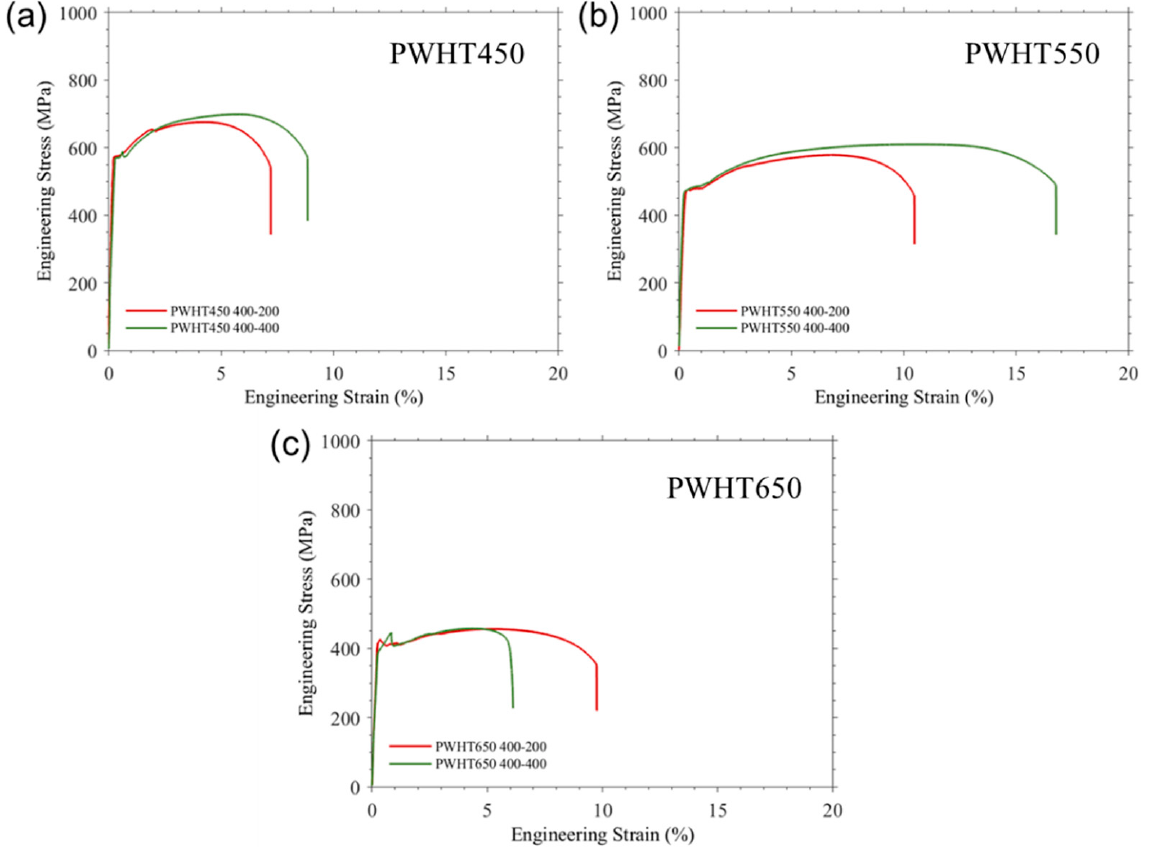
Figure 7. Representative stress-strain curves of the samples subjected to subsequent annealing with different temperatures of ( a ) 450 °C, ( b ) 550 °C, and ( c ) 650 °C. Table 4. Resultant tensile properties of FSWed DP780 with different annealing temperatures.